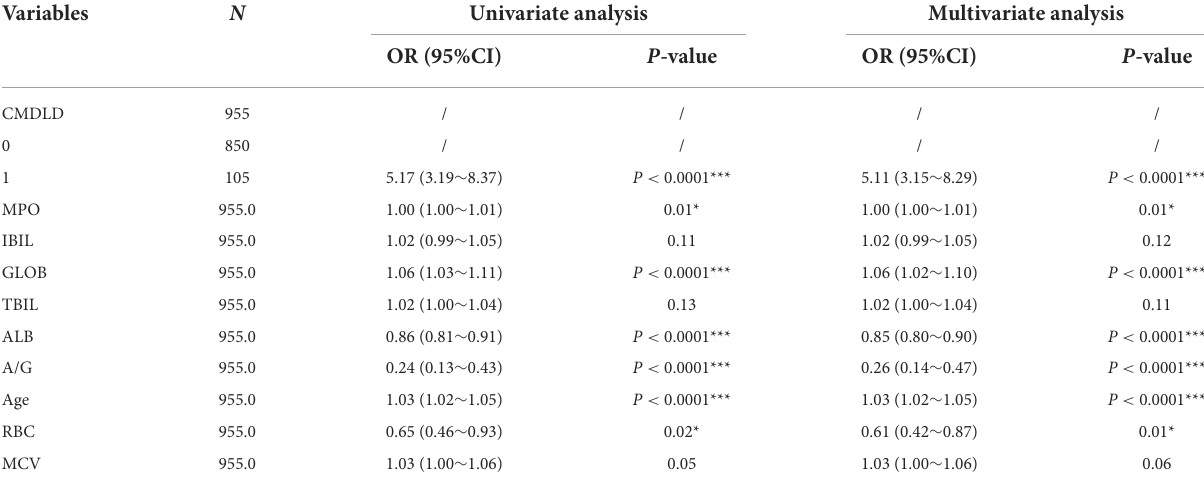
TABLE 2 Univariate and multifactorial logistic regression analysis of the occurrence of thyroid disease in coal miners. Variables N Univariate analysis Multivariate